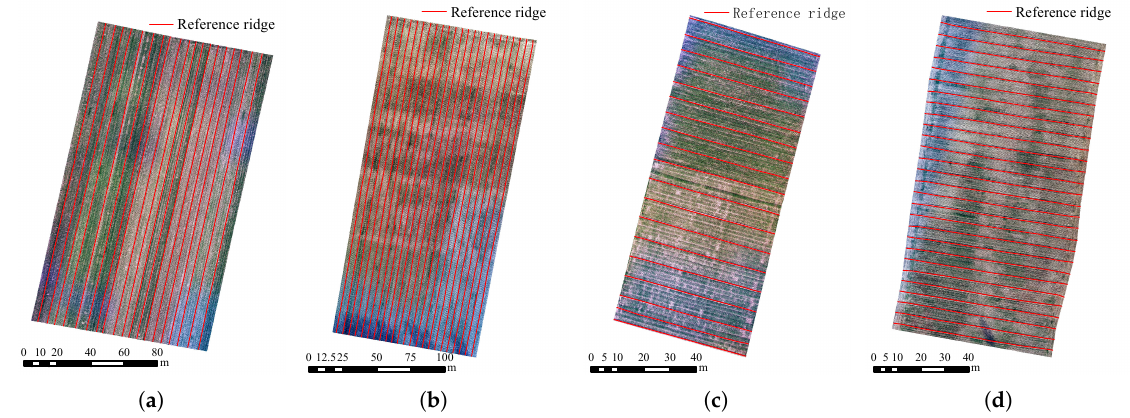
Figure 6. Validation ridges obtained by manual digitization for Plot 1 ( a ), Plot 2 ( b ), Plot 3 ( c ), Plot 4 ( d ).